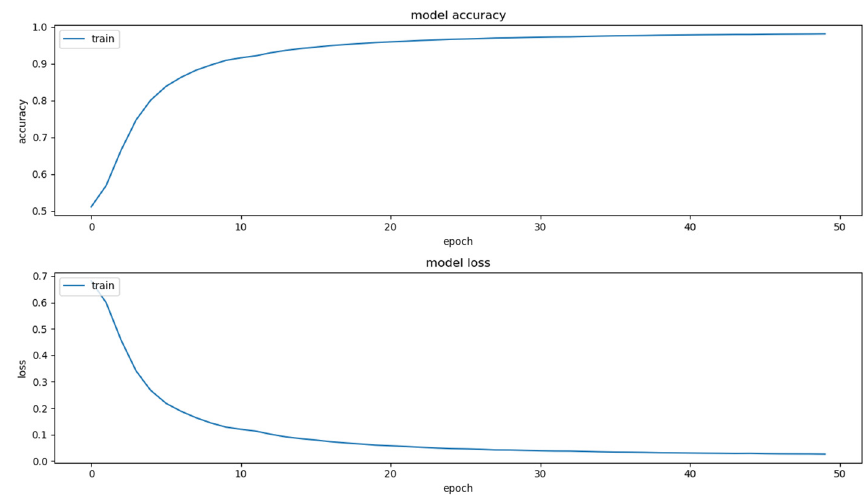
Figure 6. The training curve of the proposed self-information extraction model.